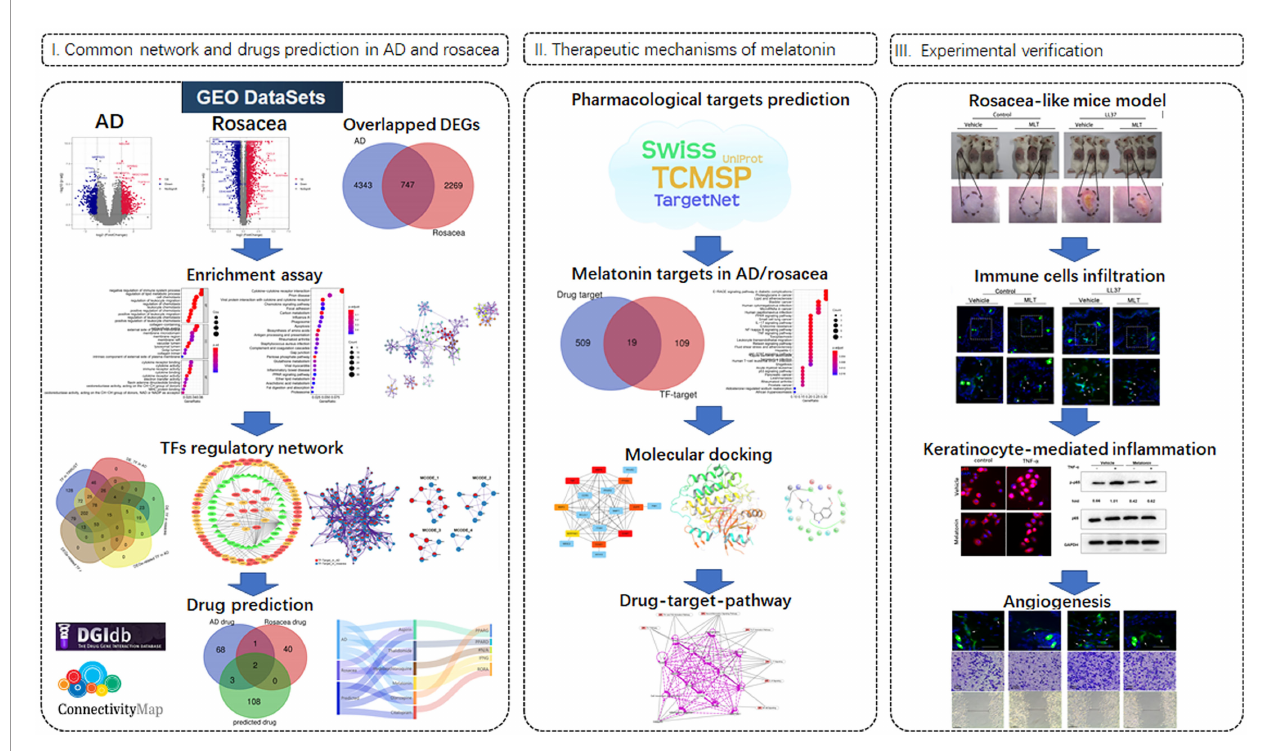
FIGURE 1 | Work fl ow of the